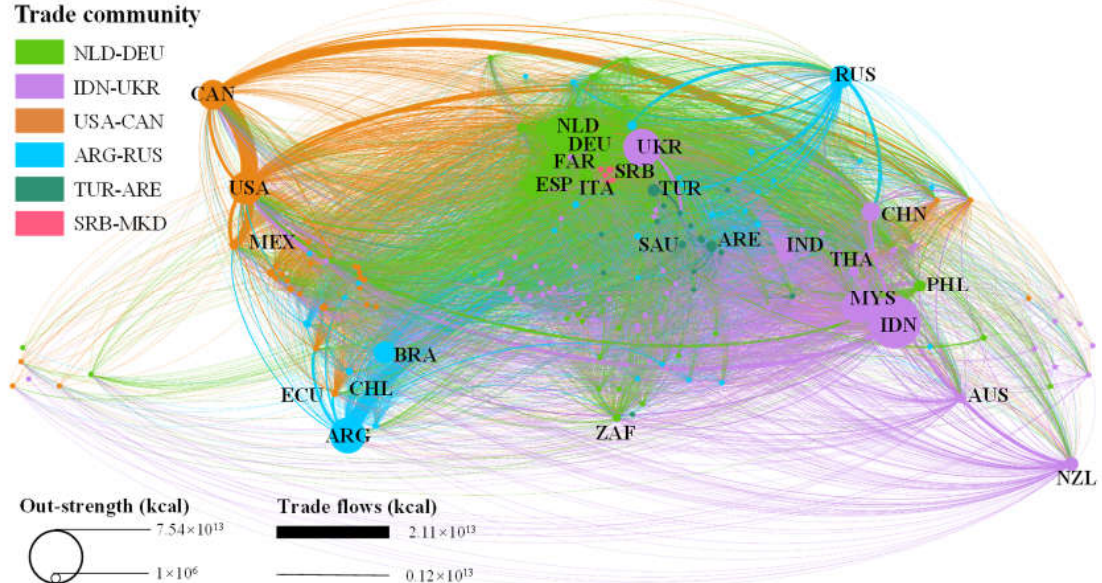
Figure 4. Community structure and flow patterns in the CCFTN.